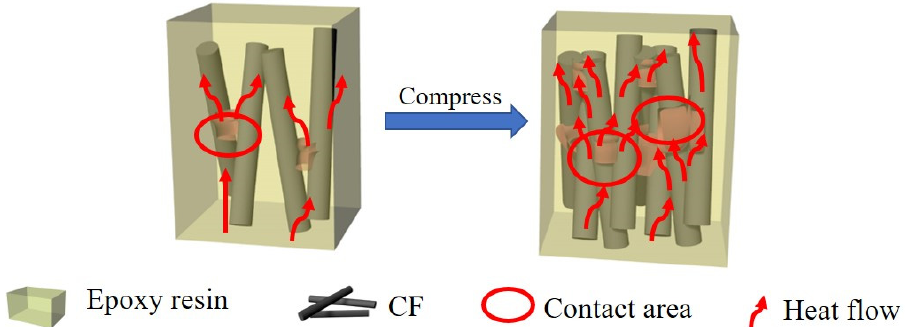
Figure 9. The mechanism of the heat conduction in the CF/C/EP composite.